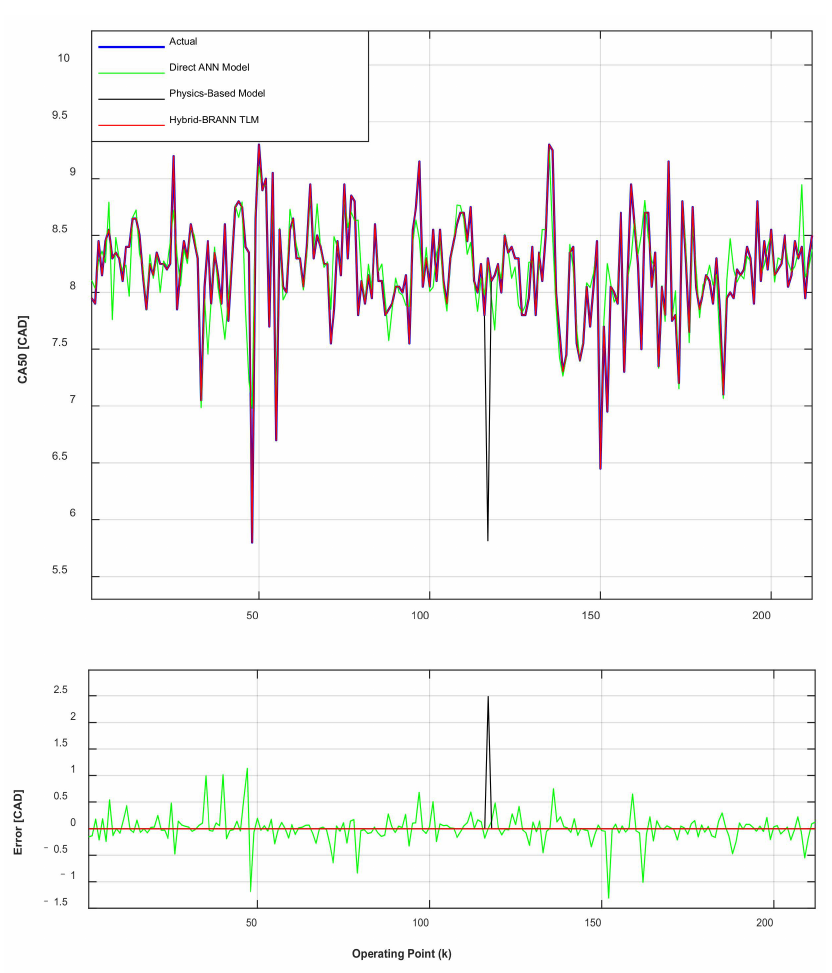
Figure 26. Comparison of the actual CA50, physics-based model prediction, hybridized prediction, and ANN